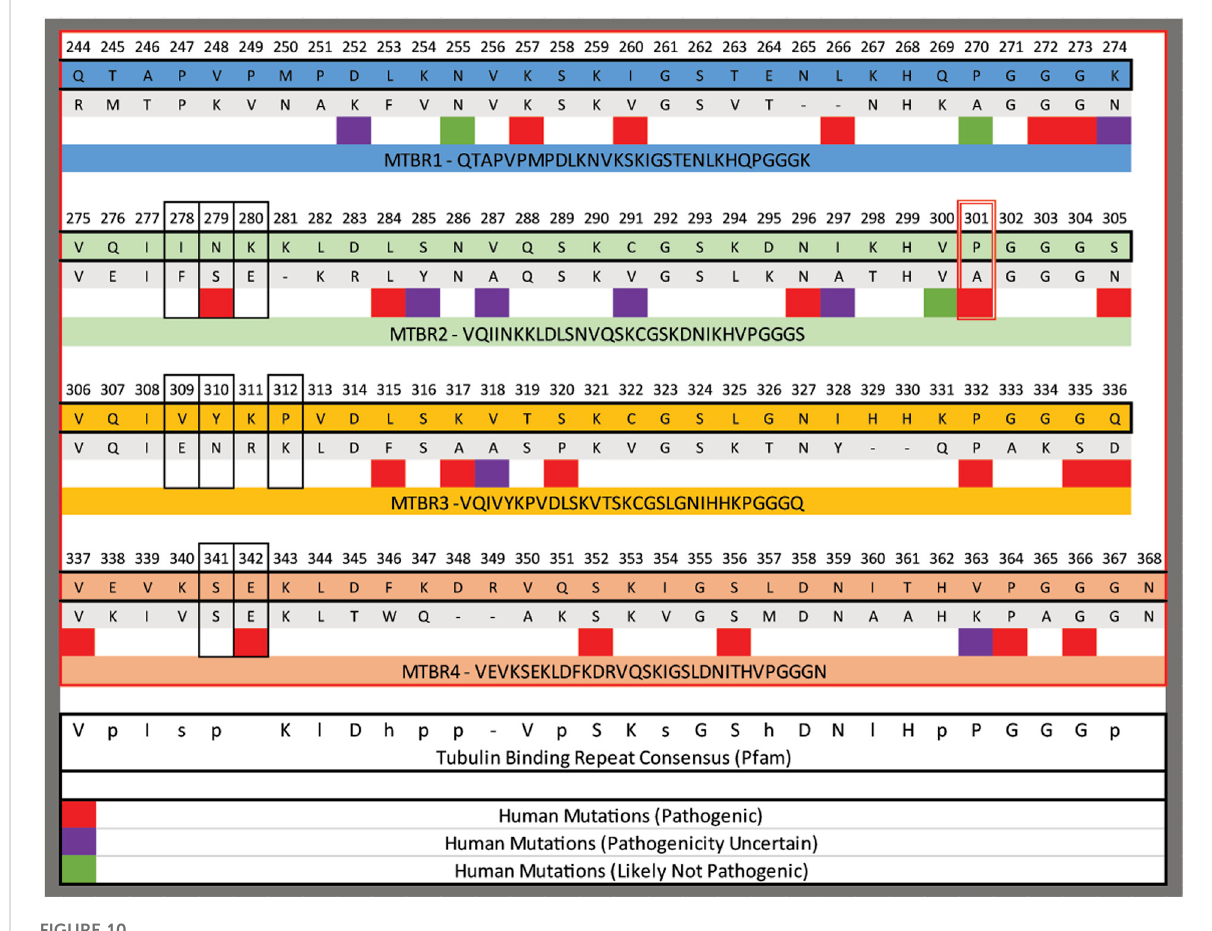
FIGURE 10 Alignmentofthemicrotubulebindingrepeats(MTBR)fromhumantauandtheC .elegan sPTL-1.Thedomainswerealignedtoeachotherusing Clustalomega,numbering isfromhTau40.Theredbox outlinesthepositionofP301mutatedintheP301Slinesandtheblackboxesoutline residues modi fi ed in the 3PO variant. Below speci fi c amino acids are regions that have been identi fi ed to in human populations, and the pathogenicity indicated by the colour code as